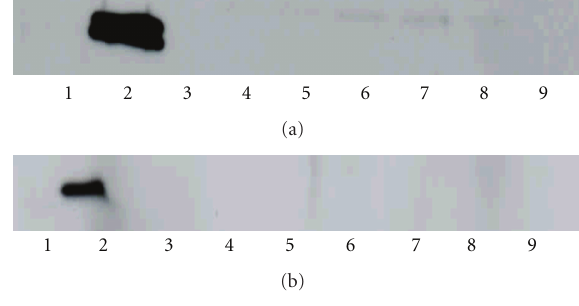
Figure 1: Western blots with a polyclonal antibody directed against LMP2 or LMP7 subunits of the immunoproteasome of samples of BAL supernatant and BAL cell pellet lysate obtained from ARDS patients. (a) LMP2 immunoproteasome protein was detected in both BAL supernatant and cell pellet in all ARDS patients. Lanes